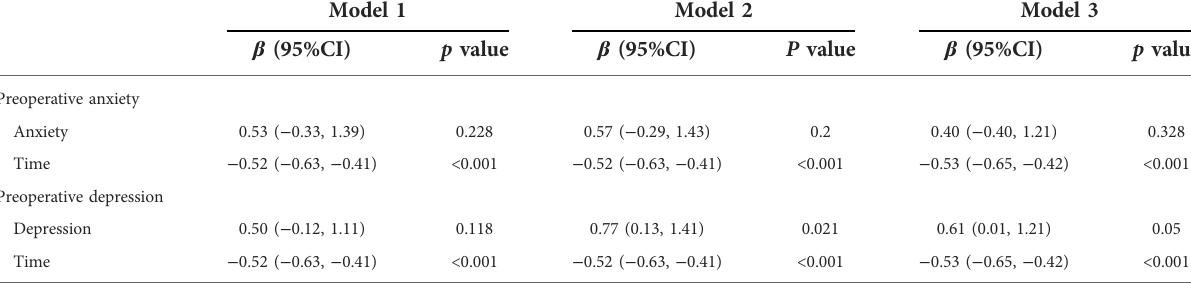
Model 1: Crude model. Model 2: adjusted for age, sex. and education. Model 3: further adjusted for the number of excisional